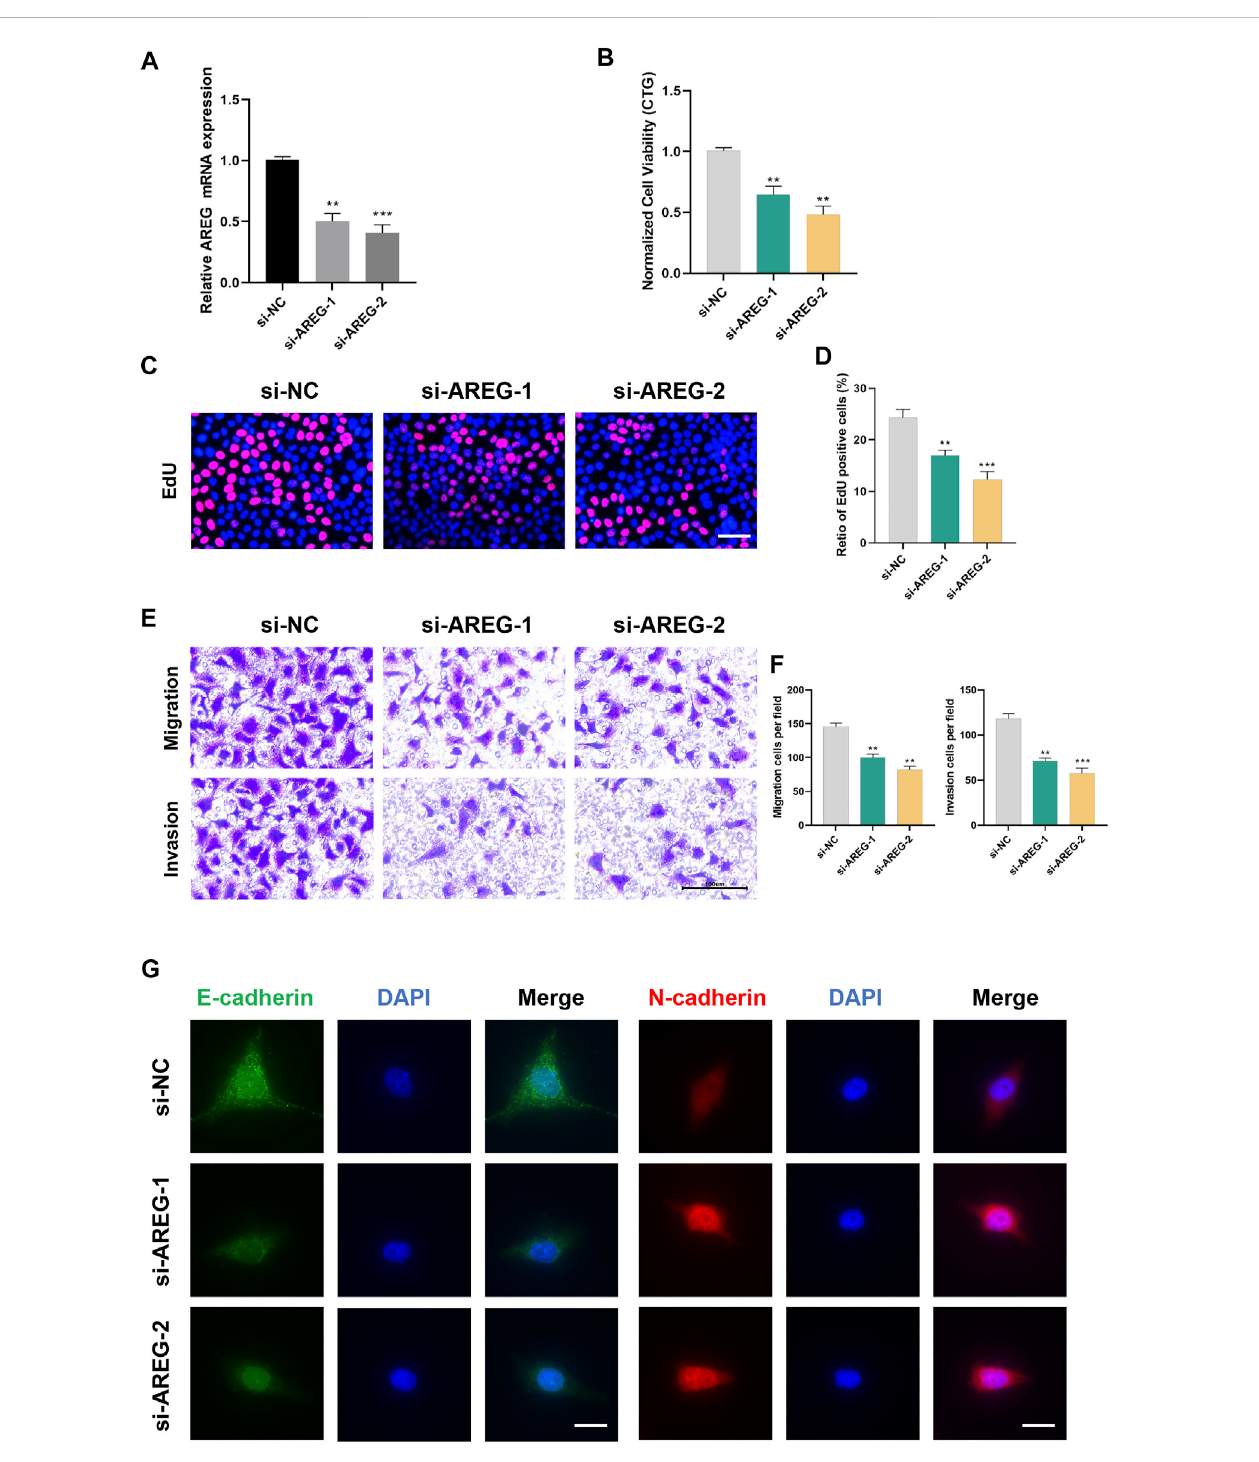
FIGURE 10 SilencingAREGinhibitsUMproliferationandmetastasis. (A) Transfectionef fi ciencywasdetectedbyqRT-PCR.Cellproliferationwasdetectedby (B) CTG and (C,D) EdU assays. Scale bar, 50 mm. (E,F) The role of AREG on cell metastasis was tested by transwell assay. (G) Downregulation of AREG enhanced N-cadherin and inhibited E-cadherin by Immuno fl uorescence. Scale bar, 50 mm (** p < 0.01, *** p <